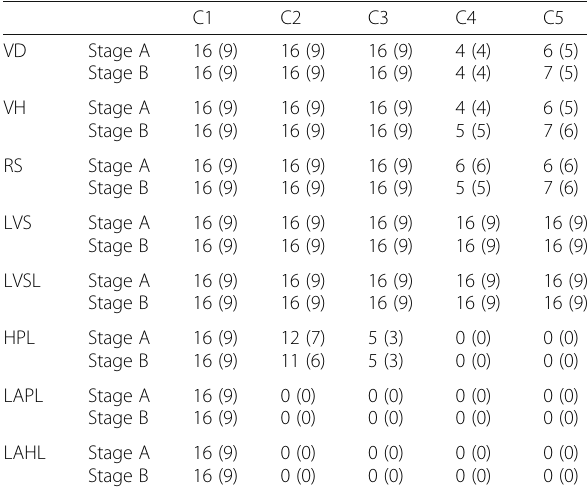
Table 4 Number of cases with measurable parameters at stages A and B in five conditions ( N = 16)